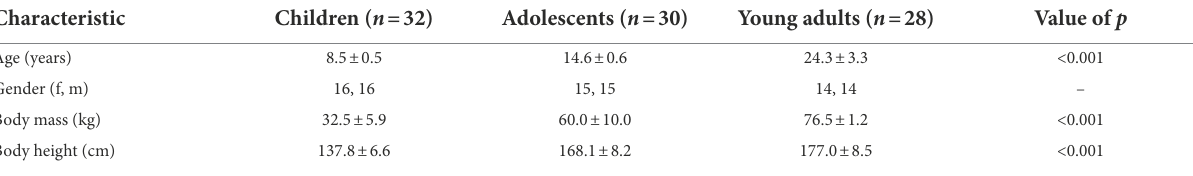
TABLE 1 Characteristics of the study participants by